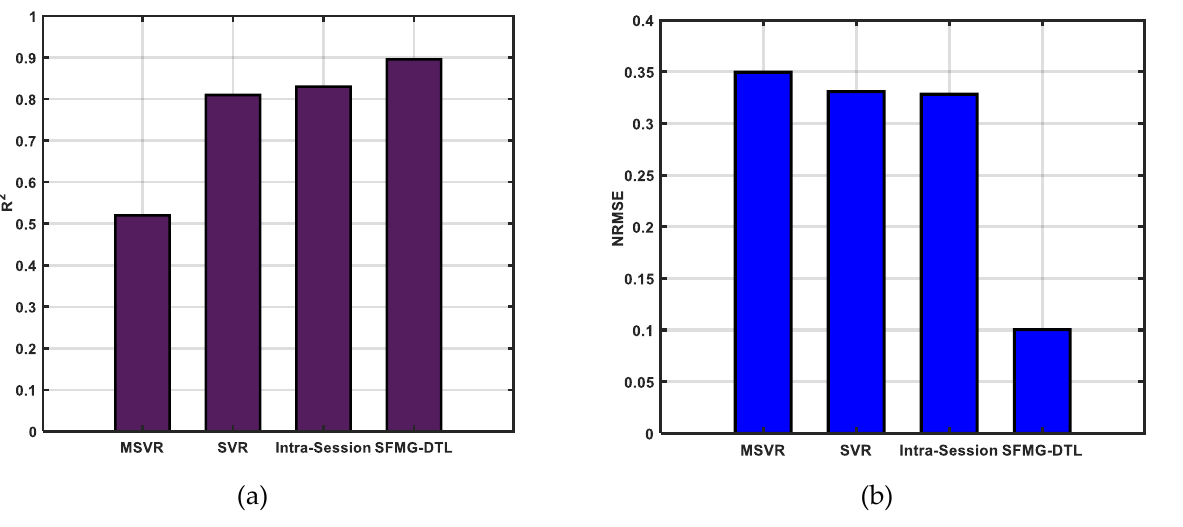
Figure 7. Performances of ML and DL models in case i: on target dataset 1 (supervised domain adaptation): ( a ) estimation accuracies (R 2 ) and ( b ) error in estimation (NRMSE). Averaged values (Model X and Model Y) are reported for SVR, intra-session, and SFMG-DTL.